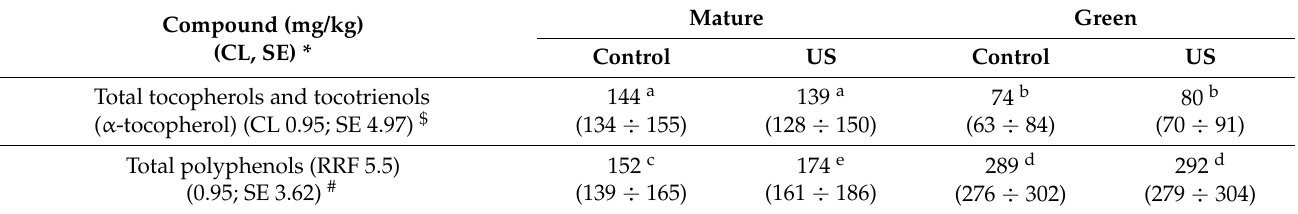
Table A2. Total tocopherol and tocotrienol, and polyphenol contents of Taggiasca oil samples (mg/kg).